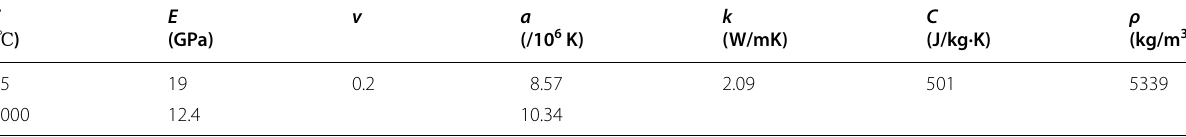
Table 2 Material properties of CMAS-penetrated TC layer [42]